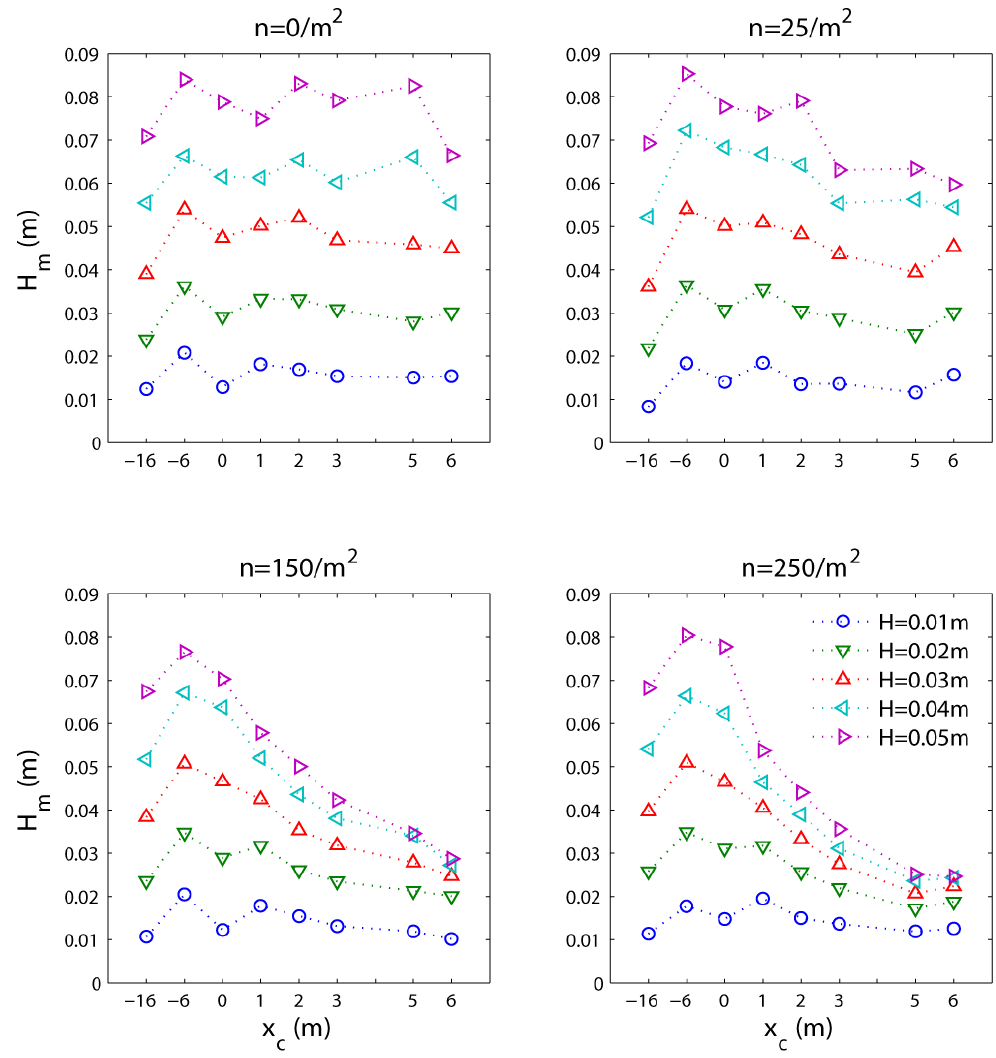
Figure 8. Mean wave height, H m , recorded along the flume, from the nearest sensor to the wave maker ( x c = − 16m), to the beginning of the sand bed ( x c = − 6m) to the end of the array ( x c = 6m. Notice negative x c coordinates are not in